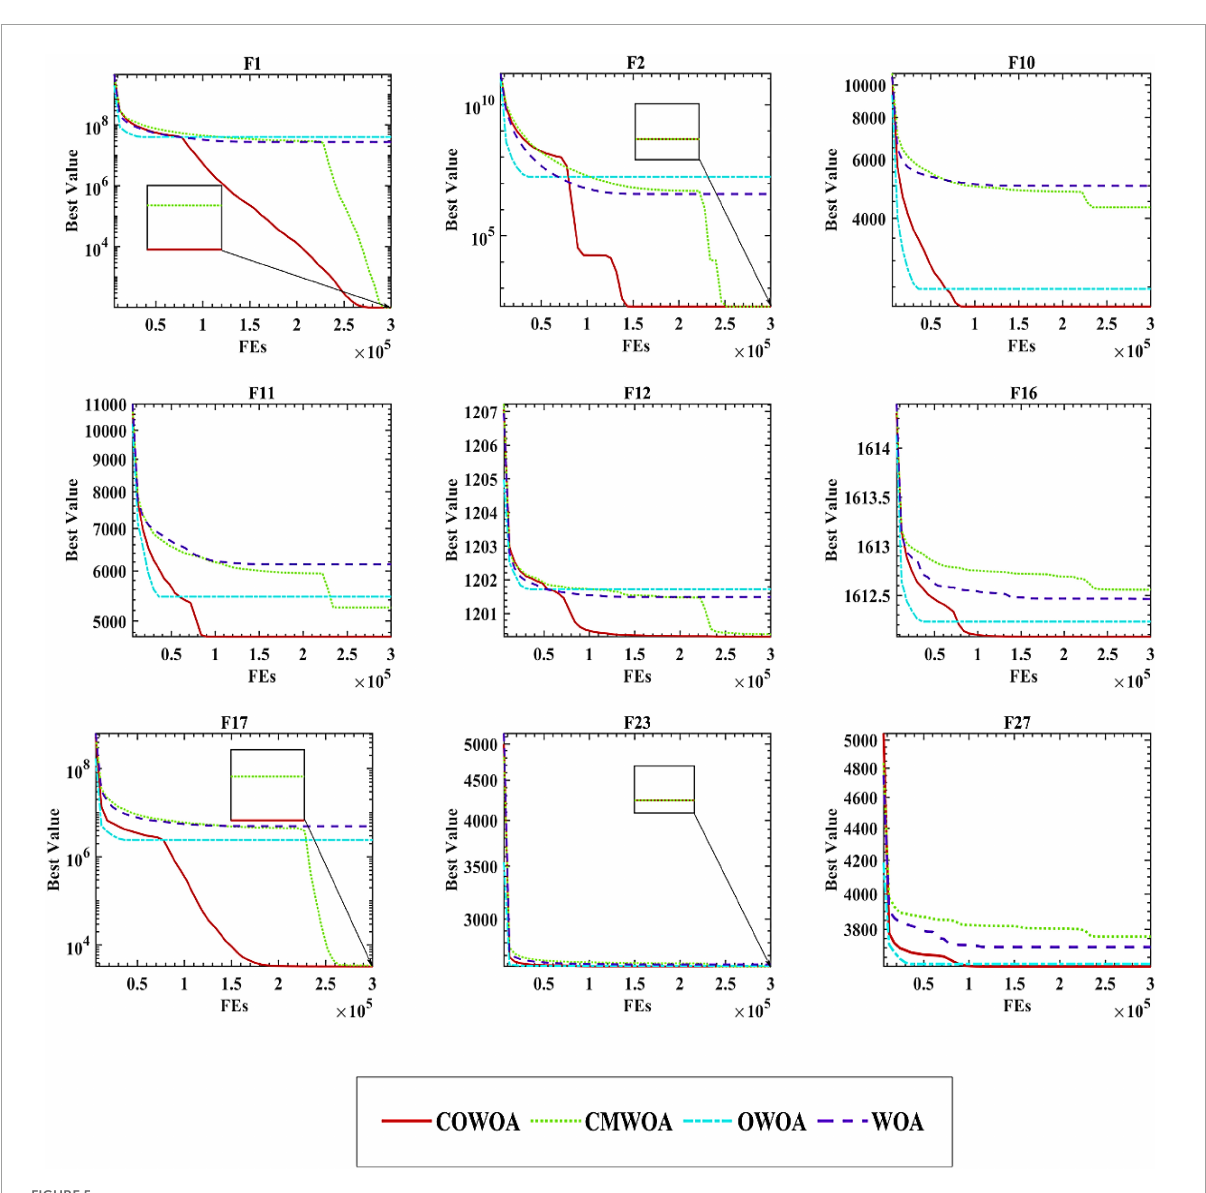
FIGURE5 Convergence curves of COWOA performance